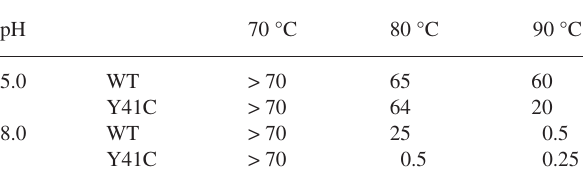
Table 3. Thermal stability (half-lives, h) of the wild type (wt) Solfo- lobus solfataricus amidase and its Y41C mutant measured at pH 5.0 and 8.0.